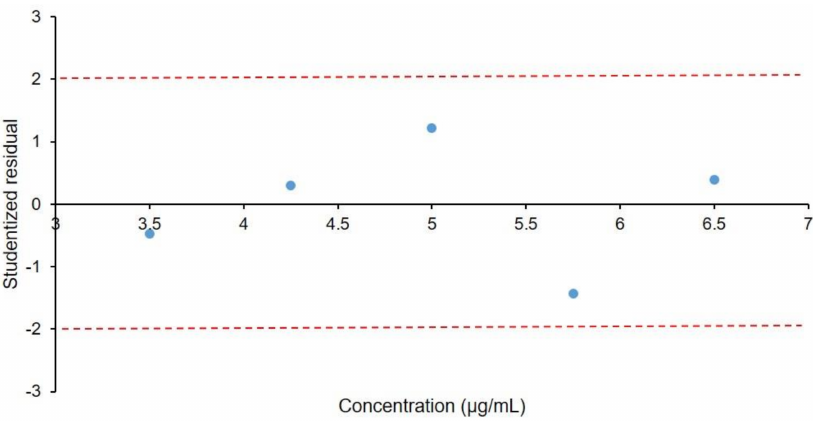
Figure 8. Studentized residual